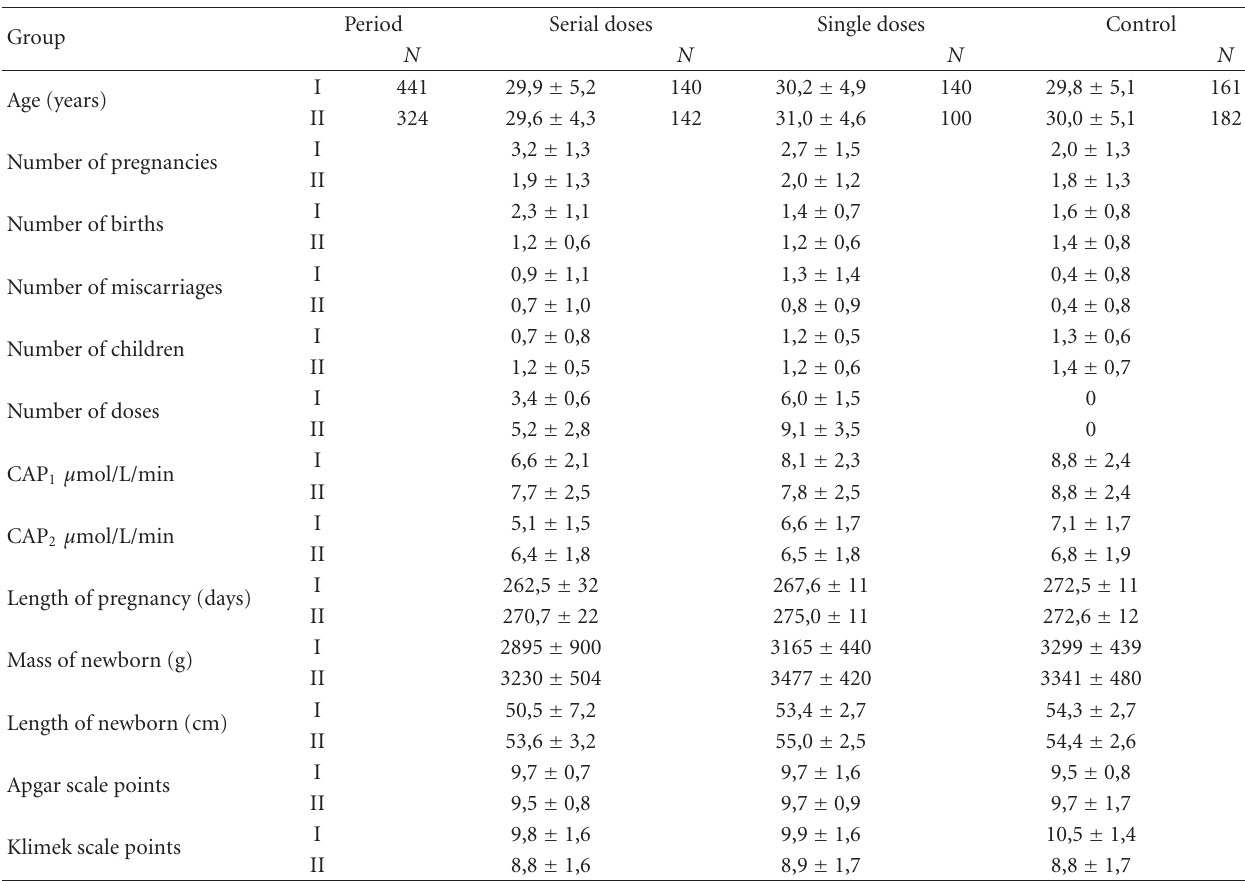
Table 2: Results of treatment of infertile women in periods I (1991–1992) and II (2001–2004) with single and serial doses from the beginning of the